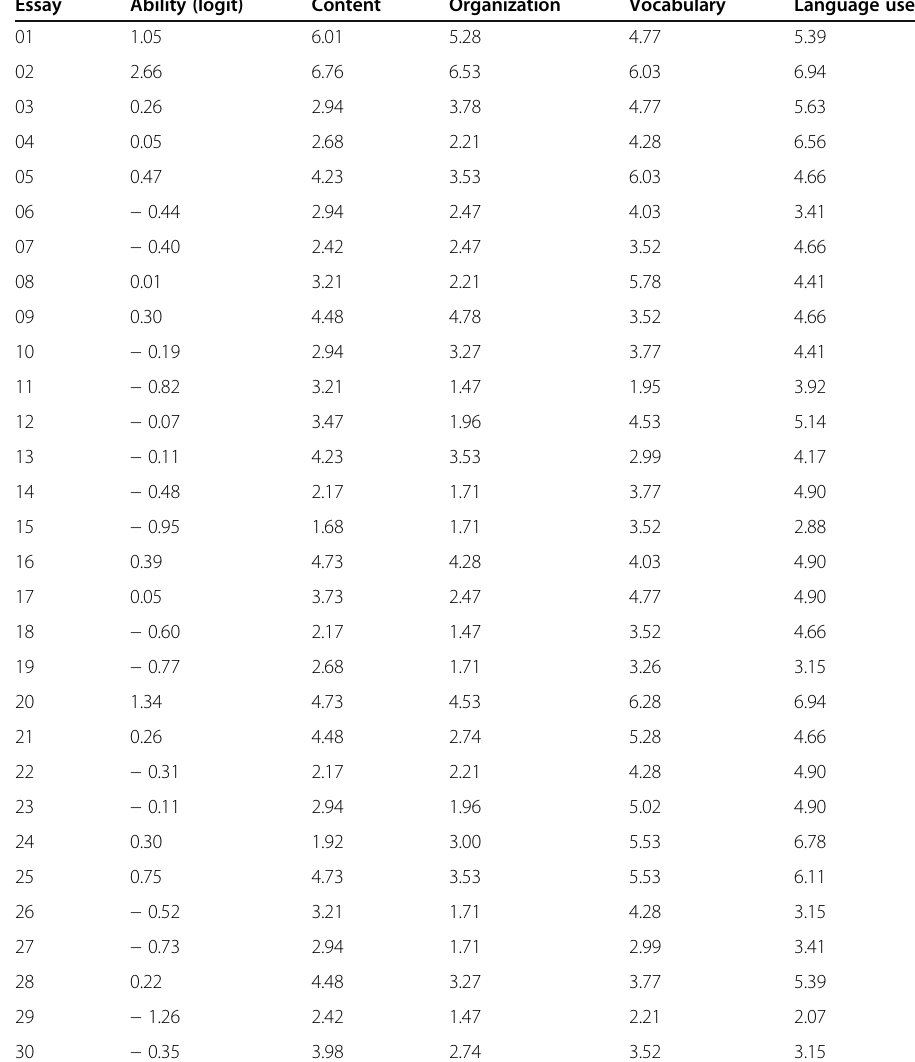
Table 6 Fair-average scores of the 30 screened